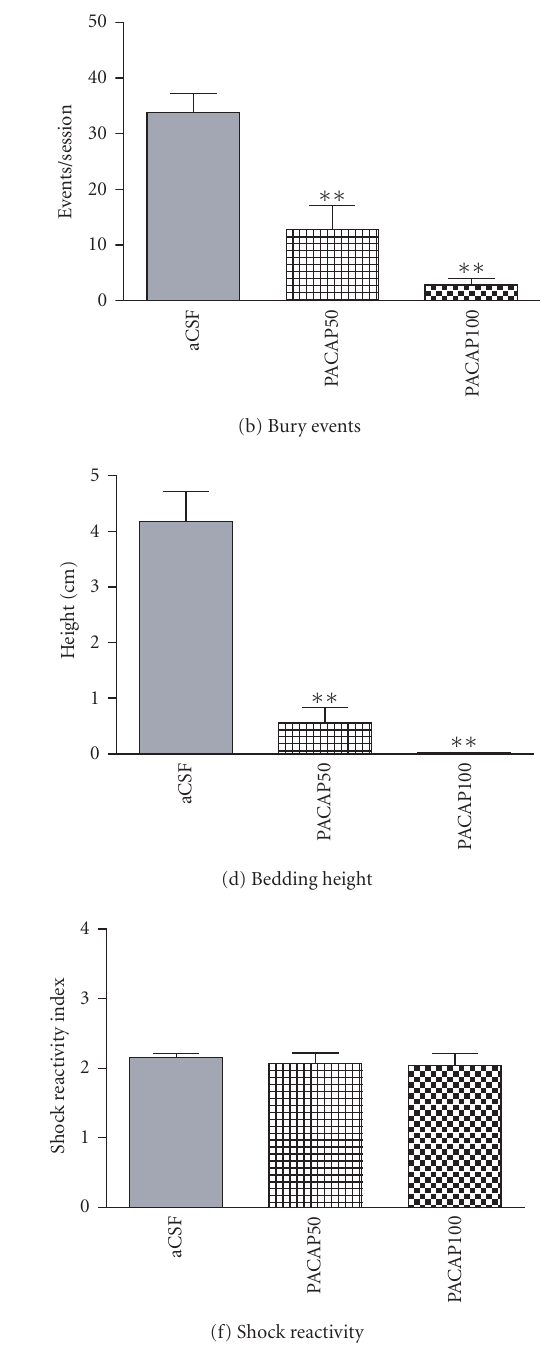
Figure 4: E ff ect of intra-CeA PACAP administration on shock-probe burying and shock-related behaviors. Latency to bury the electrified shock probe (a) was significantly increased in PACAP-injected animals whereas burying events (b) and time (c) and the height of bedding over the probe (d) were reduced. The number of probe-contact-induced shocks (e) was significantly reduced in PACAP-injected animals but shock reactivity (e) was unaltered. ∗ P < . 05 and ∗∗ P ≤ . 001 compared to aCSF